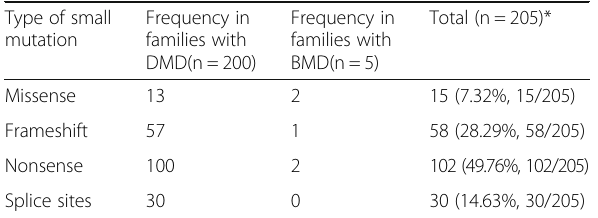
Table 2 Frequency of small mutations at